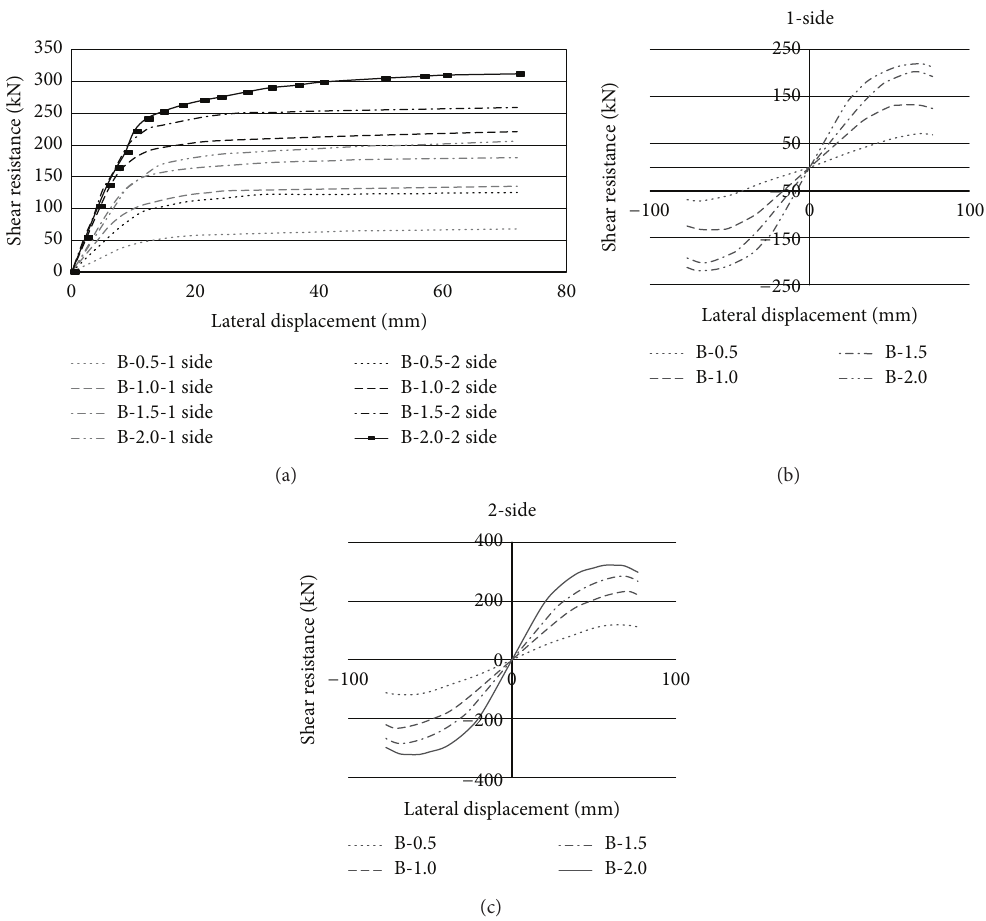
Figure 4: Curves of specimens B. (a) Monotonic curves. (b) Hysteretic envelope curves 1-side. (c) Hysteretic envelope curves